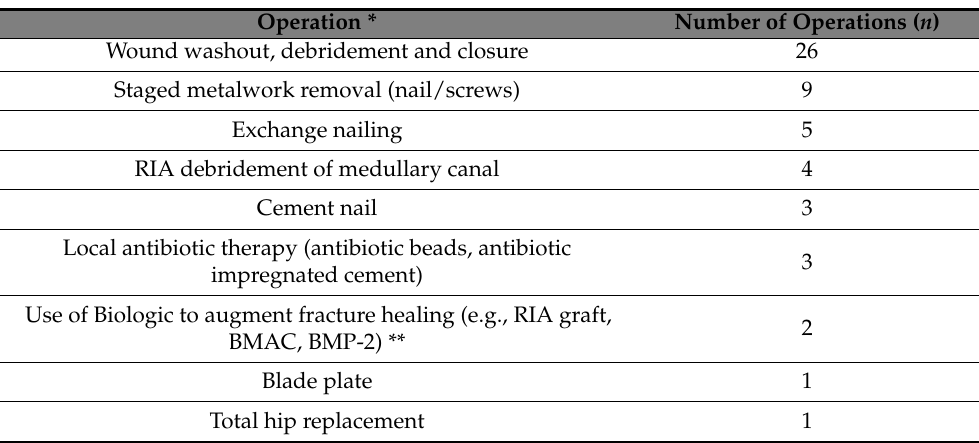
Table 3. Revision operation performed for patients with deep